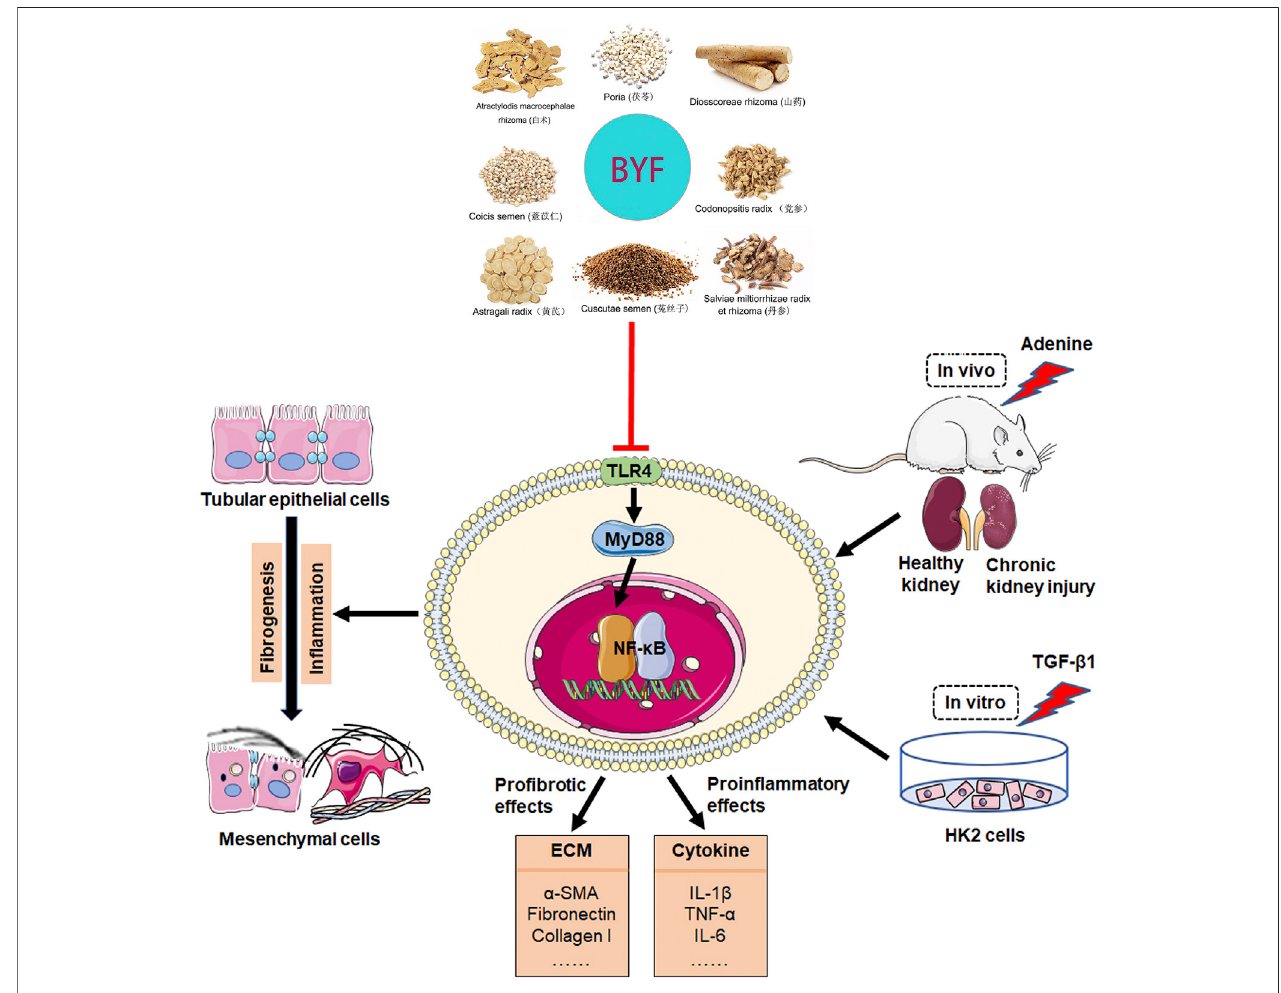
FIGURE 8 | BYF regulation on the TLR4/NF- κ b signaling pathway in CKD.